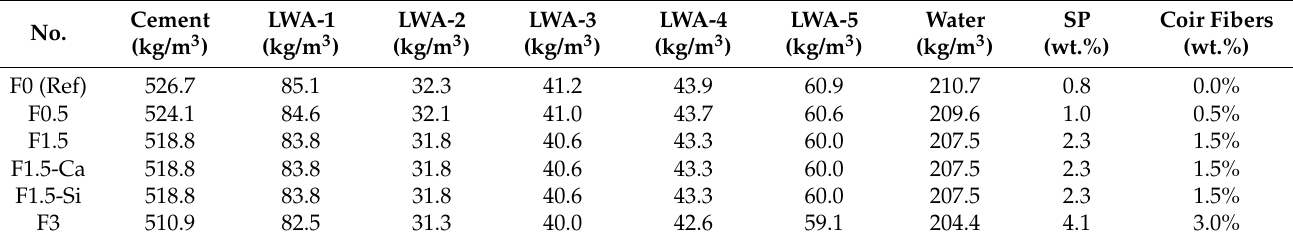
Table 3. Mix design of light-weight aggregate concrete